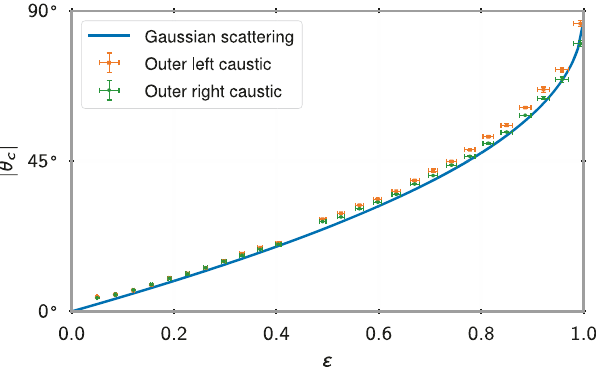
Fig. 5 Maximal scattering angle ∣ θ c ( ε ) ∣ vs. ε . Angle obtained by fi tting Eq. (4) to the outer left (orange squares) and right (green circles) caustics in the experimental images. The standard deviation at each ϵ provides an estimate of the uncertainty based on three data points. The solid line is the classical result θ c ( ε ) for a particle with kinetic energy K = mv 2 /2 = ε U 0 scattering off of a Gaussian potential. The small differences between the left and right θ c above ε ≈ 0.5 is likely due to slight asymmetries in optical